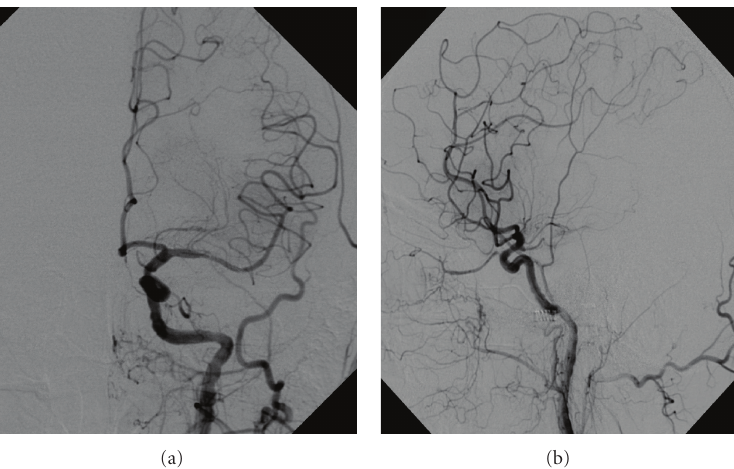
Figure 5: Follow-up angiogram immediately after re-opening of the left MCA (left ICA injection), anteroposterior (a) and lateral (b) views show a patent, though slightly narrower left MCA